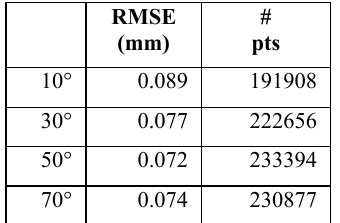
Table 1: RMSE and number of “good points” in the DTM produced with the original (uncompressed) images at different illumination angles